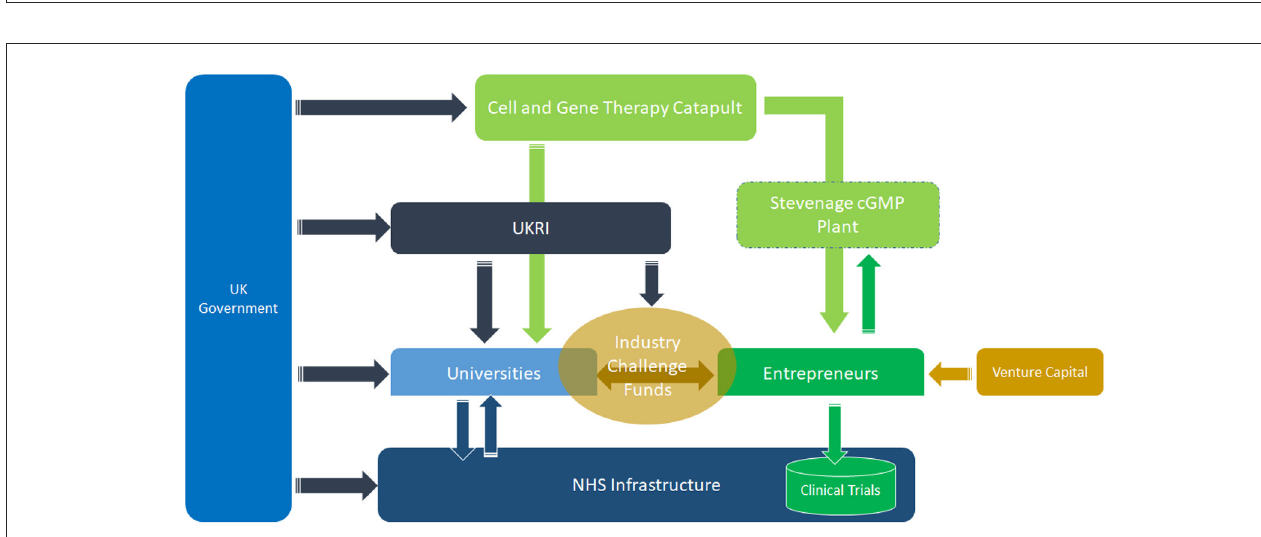
FIGURE6 Institutions that support value chain bridging and early-stage de-risking in the UK regenerative medicine sector. Source: Author based on interviews on the RegeNableMed